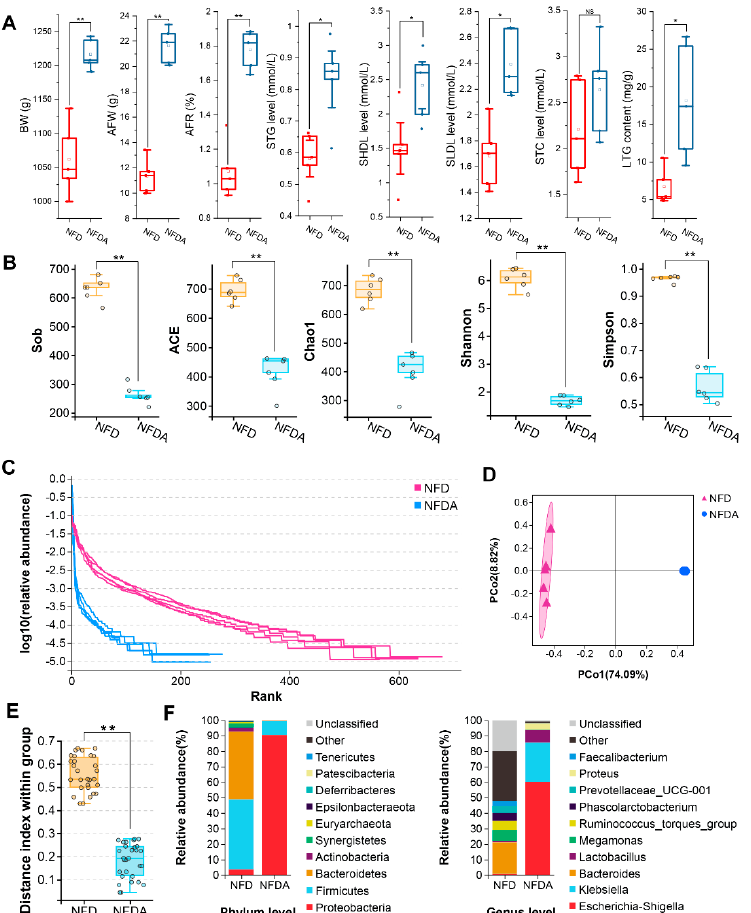
Figure 1. The impact of antibiotic treatment on lipogenesis and cecal microbiota of chicken. ( A ) BW, AFW, AFR, STG level, SHDL level, SLDL level and liver TG level of chickens in antibiotic-treated ( n = 5) and control ( n = 5) groups. Oral antibiotics significantly promote the lipogenesis of chicken. ( B ) Comparison of alpha diversity indices of cecal microbiota between control and antibiotic treatment groups. ( C ) Comparison of Rank curve of cecal microbiota between control and antibiotic treatment groups. ( D ) PCoA of beta diversity based on the unweighted UniFrac analysis of the operational taxonomic units (OTU) level. ( E ) Significance test of differences in beta diversity of cecal microbiota between control and antibiotic treatment groups using Welch’s t-test. ( F ) Cecal microbiota composition at the phylum and genus levels. * p < 0.05, ** p < 0.01, NFD ( n = 5), NFDA ( n = 5).